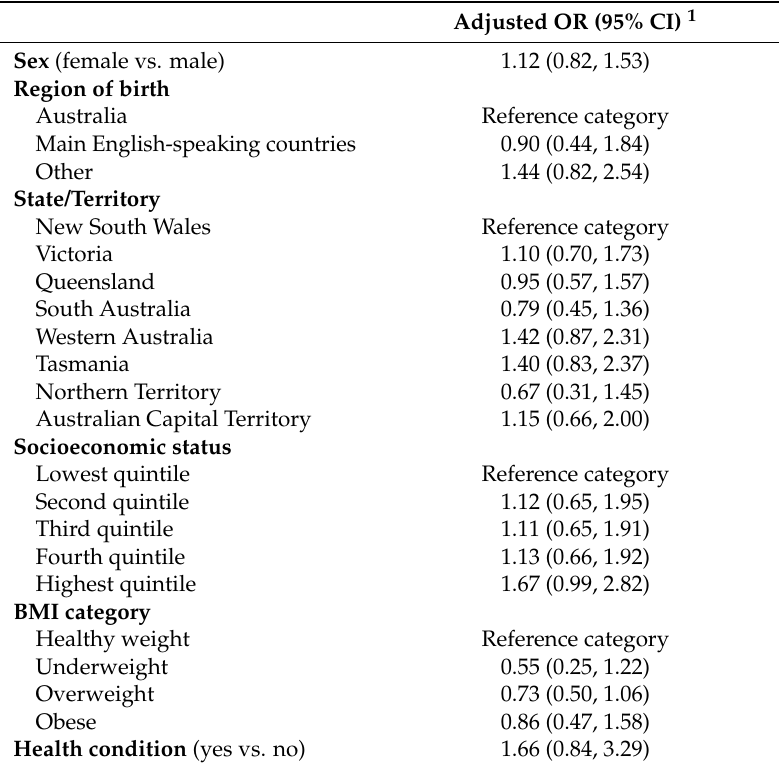
Table 2. Adjusted logistic regression investigating independent predictors of dietary supplement use in Australian adolescents aged 10–17 years ( n = 1317).